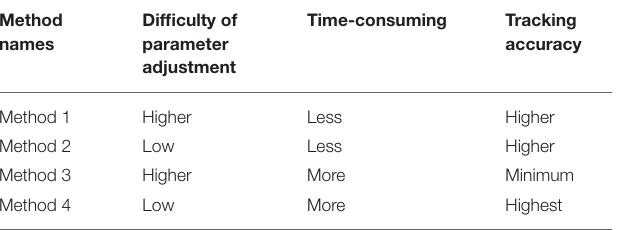
TABLE 4 | Comparison of the comprehensive performance of the improvement methods.